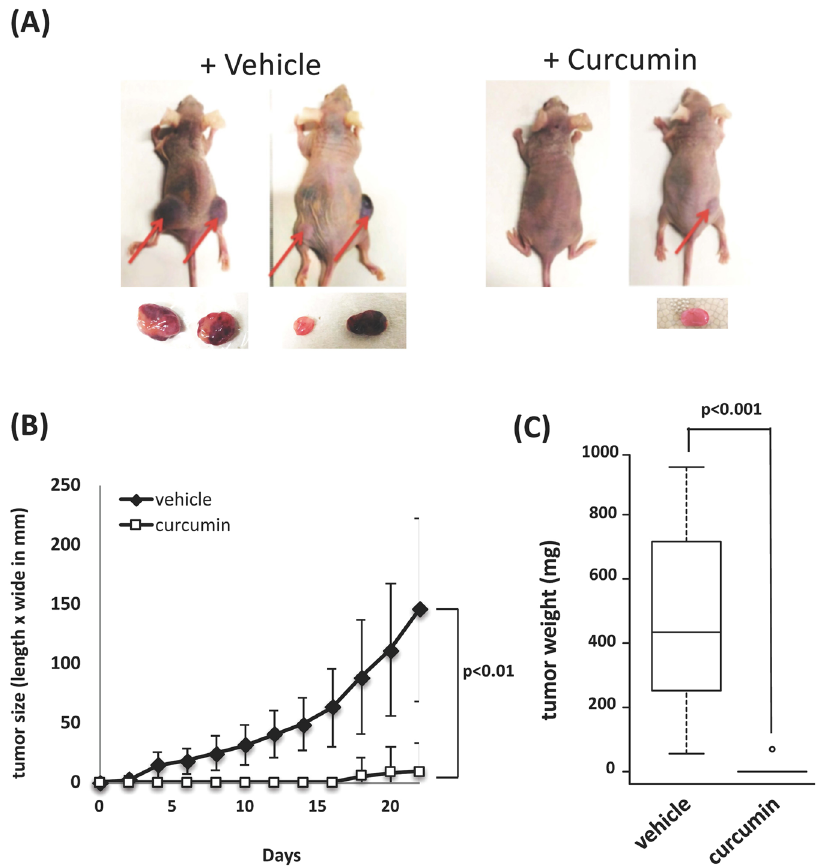
Figure 1. Curcumin suppresses tumor formation in vivo . ( A ) K562 cells (2,5 × 10 6 cells) were transplanted s.c. into the flanks of mice. Mice were then treated with curcumin (25 mg/kg BW) and vehicle (corn oil) via an i.p. injection every two days. After 22 days, mice were sacrificed and tumors were taken. Arrows indicate the tumors formed at the site of injection. ( B ) Tumor sizes (mm) were measured every 2 days. ( C ) Tumor weights after 18–22 days. vehicle (n = 9) and curcumin (n =